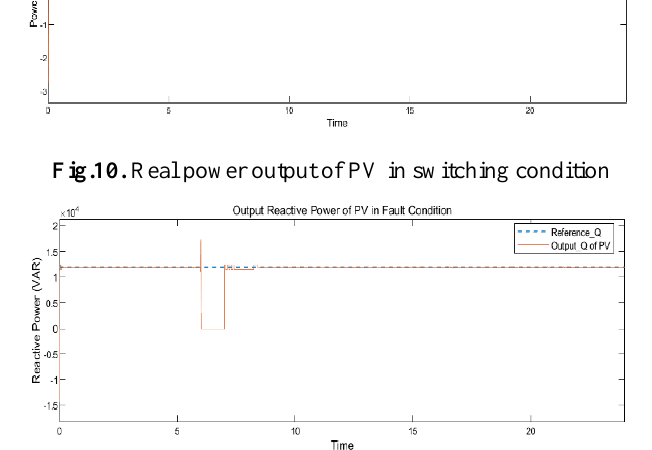
Fig. 11. Reactive power output of PV in switching condition The second source of hybrid μG is the WT. The WT is turned off at 12 seconds and turned on at 13